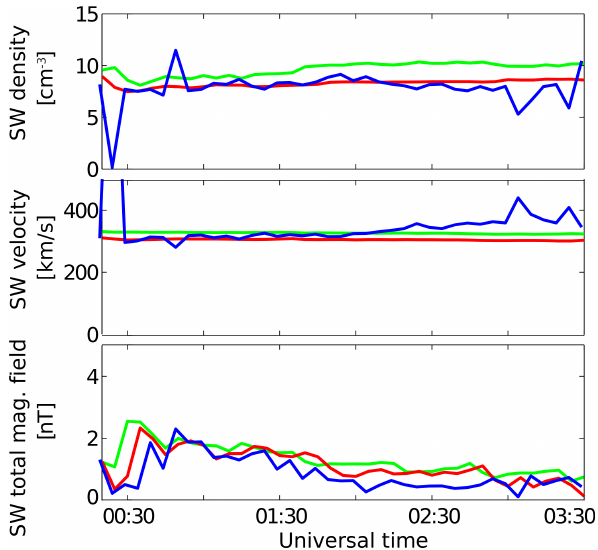
Figure 10. The reconstructed solar wind boundary conditions of the model density (top panel), the ion velocity (middle panel), and the magnetic field (bottom panel) for the magnetosheath data presented in Fig. 9 are shown in blue. Additionally, the THB (red) and OMNI (green) solar wind data during this time interval are shown.